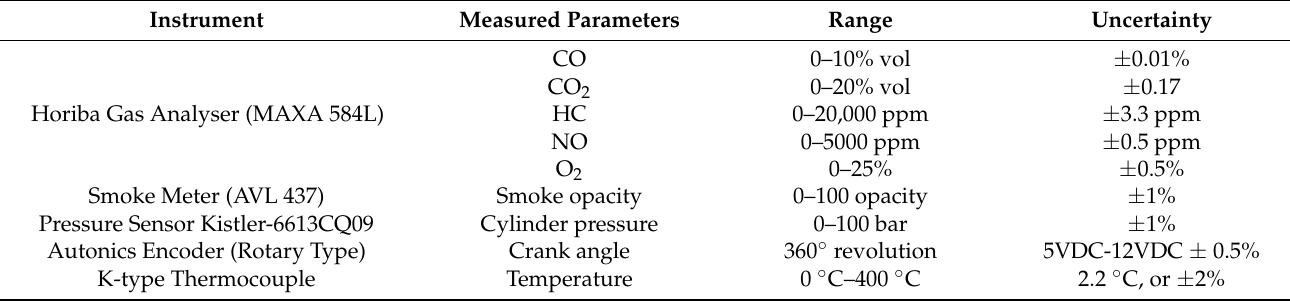
Figure 2. Photographic view of the diesel engine test rig. Table 3. Technical specifications of various instruments.